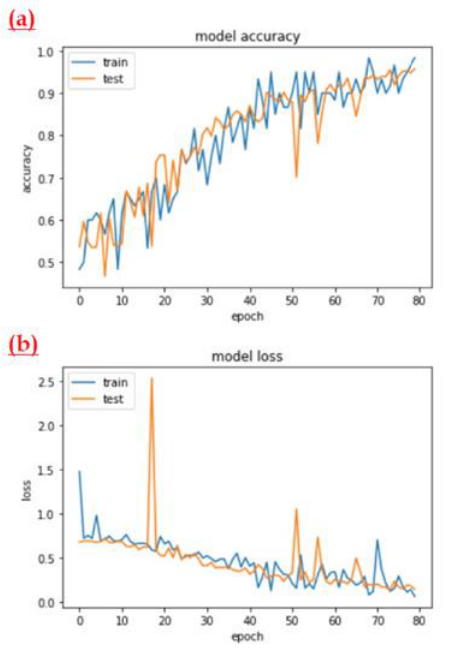
Figure 3. Example of a 3D convolution where the convolution kernel is a cube instead of a square as for a 2D convolution